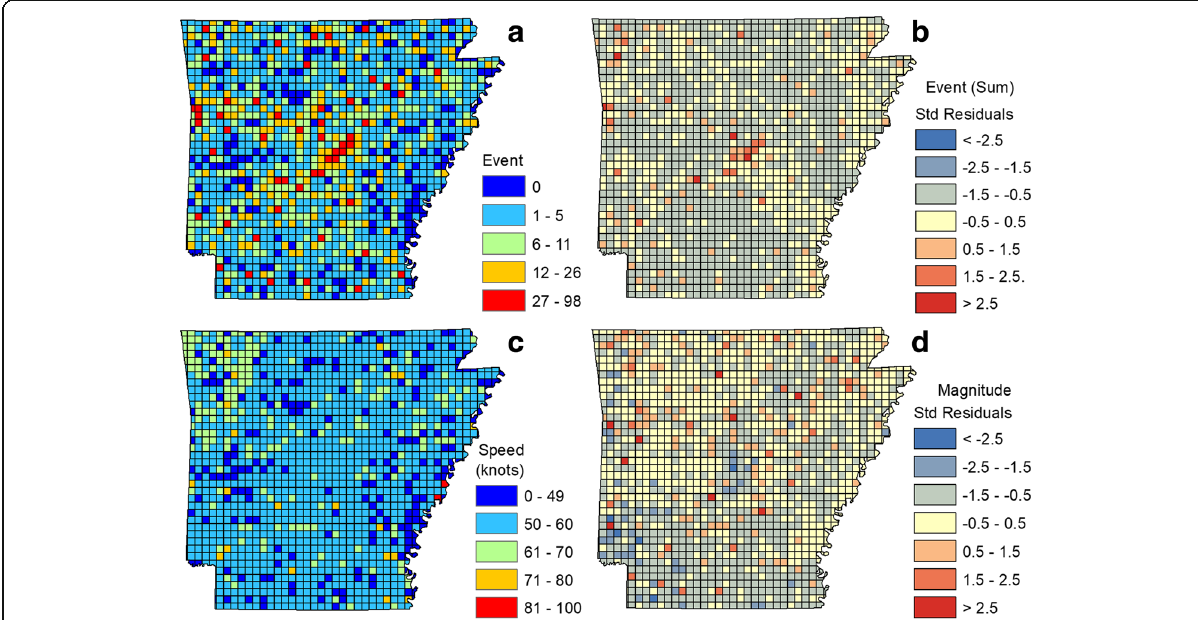
Fig. 9 Ordinary Least Squares (OLS) regression analysis for the explanatory variables influencing derechos (grid cell = 10 × 10 km): a frequency b OLS are dominant within 1 standard deviation (Std) for the explanatory variable residuals c speed d OLS show low (< 1) standard deviation for residuals signifying robustness of model